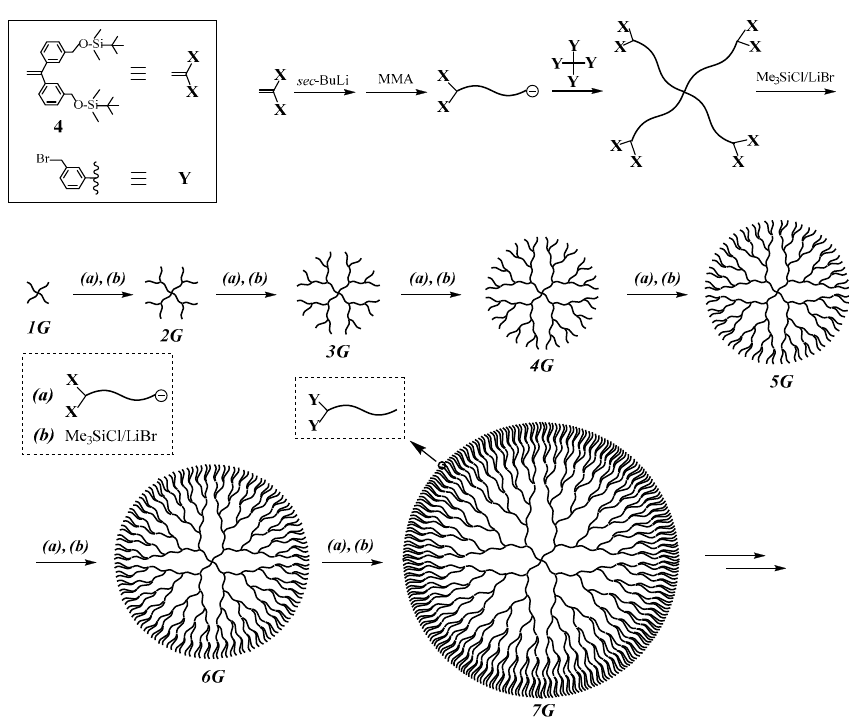
Table 4. Characterization results of the DHB (PMMA)s